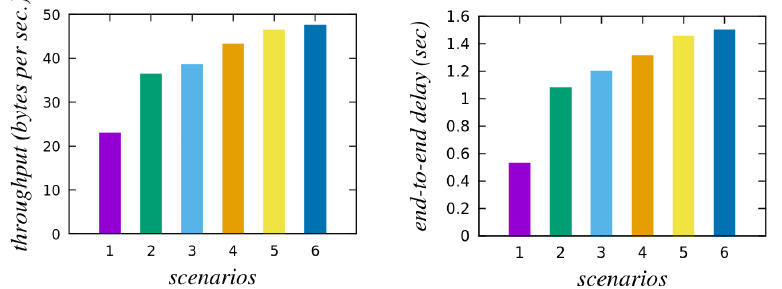
Figure 5. ( a )Throughput (bytes per second) ( b ) End-to-end delay